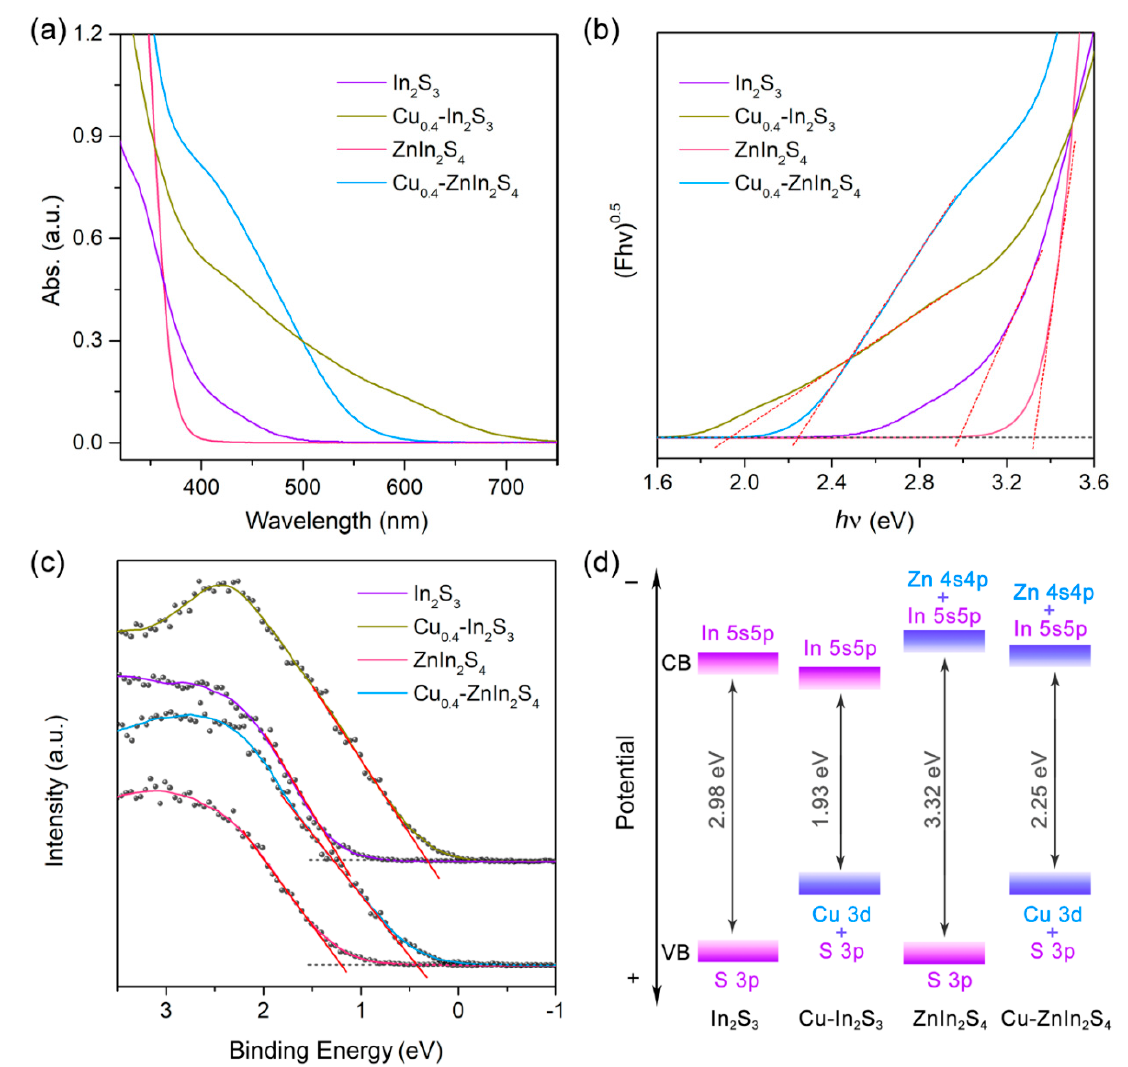
Figure 5. ( a ) The UV- vis absorption spectra, ( b ) corresponding Tauc plots, ( c ) XPS valence band spectra and ( d ) the corresponding band position alignment of In 2 S 3 , Cu 0.4 -In 2 S 3 , ZnIn 2 S 4 and Cu 0.4 -ZnIn 2 S 4 QDs.